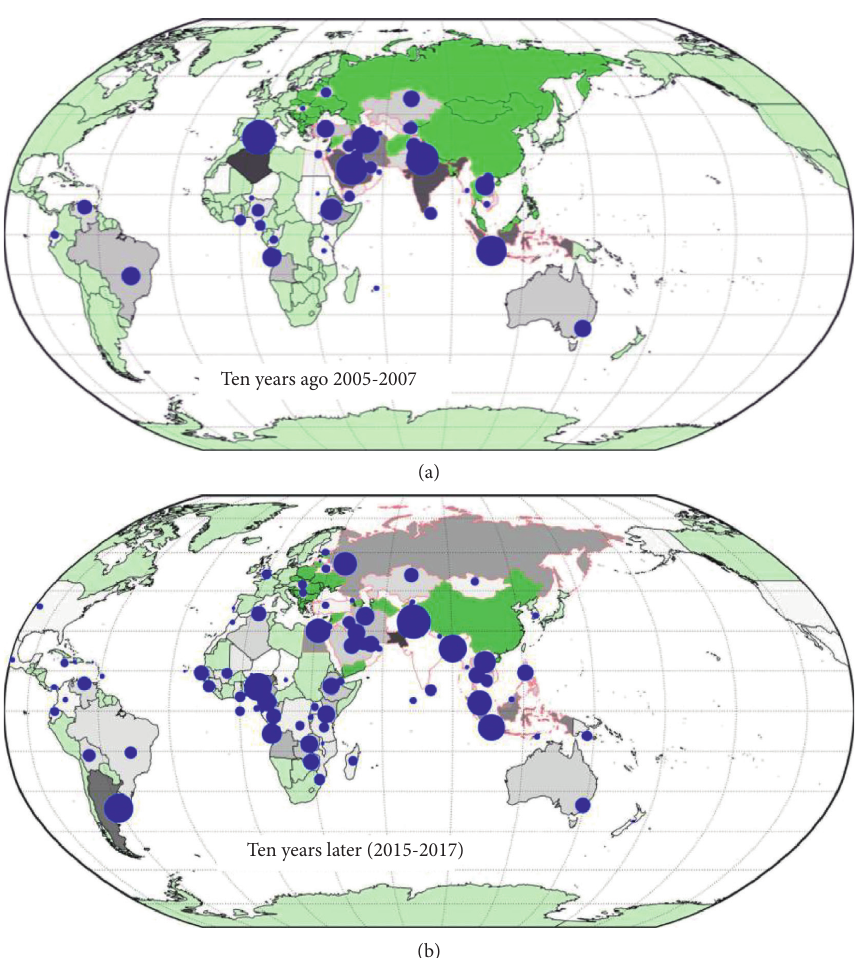
Figure 14: Changes in China’s overseas construction projects’ spatial distribution (No. 4): (a) 2005–2007; (b)